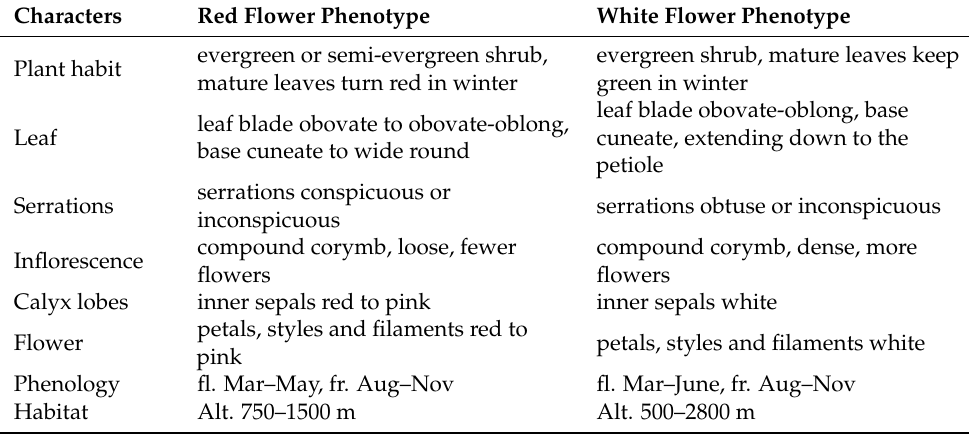
Table 6. Morphological, habit, and habitat differences between P. fortuneana individuals with red and white flower